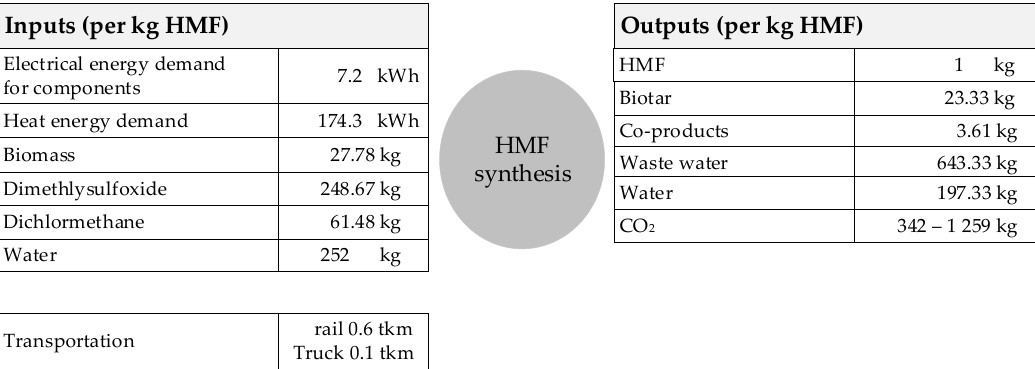
Figure 1. Production process of HMF (following the pilot process of the literature [15]).